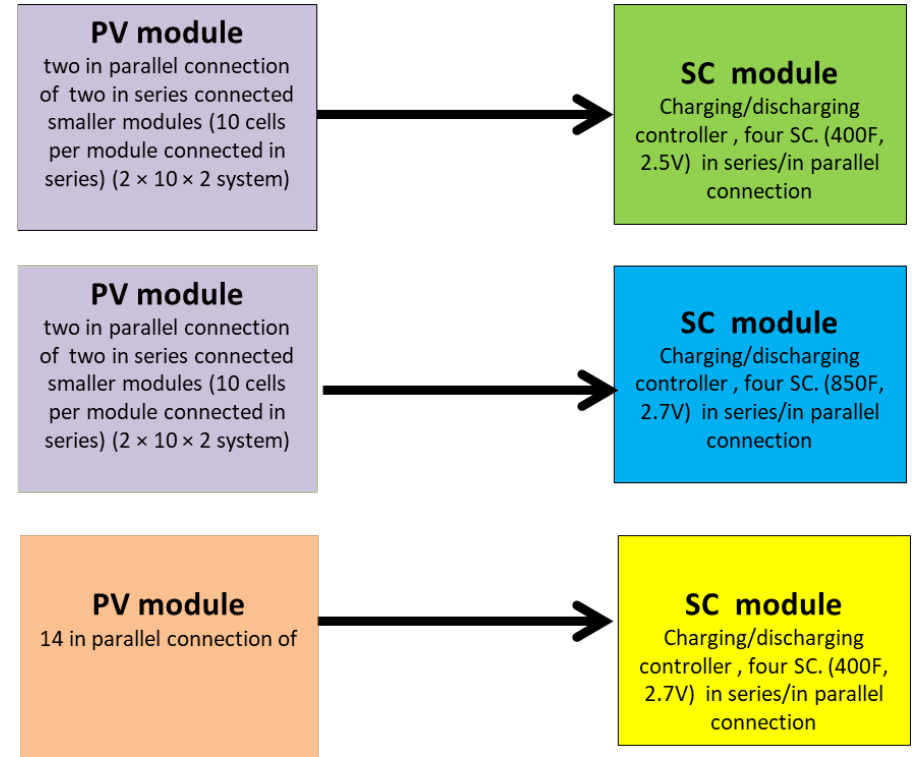
Scheme 1. Graphical representation of different architecture studied in the current work.